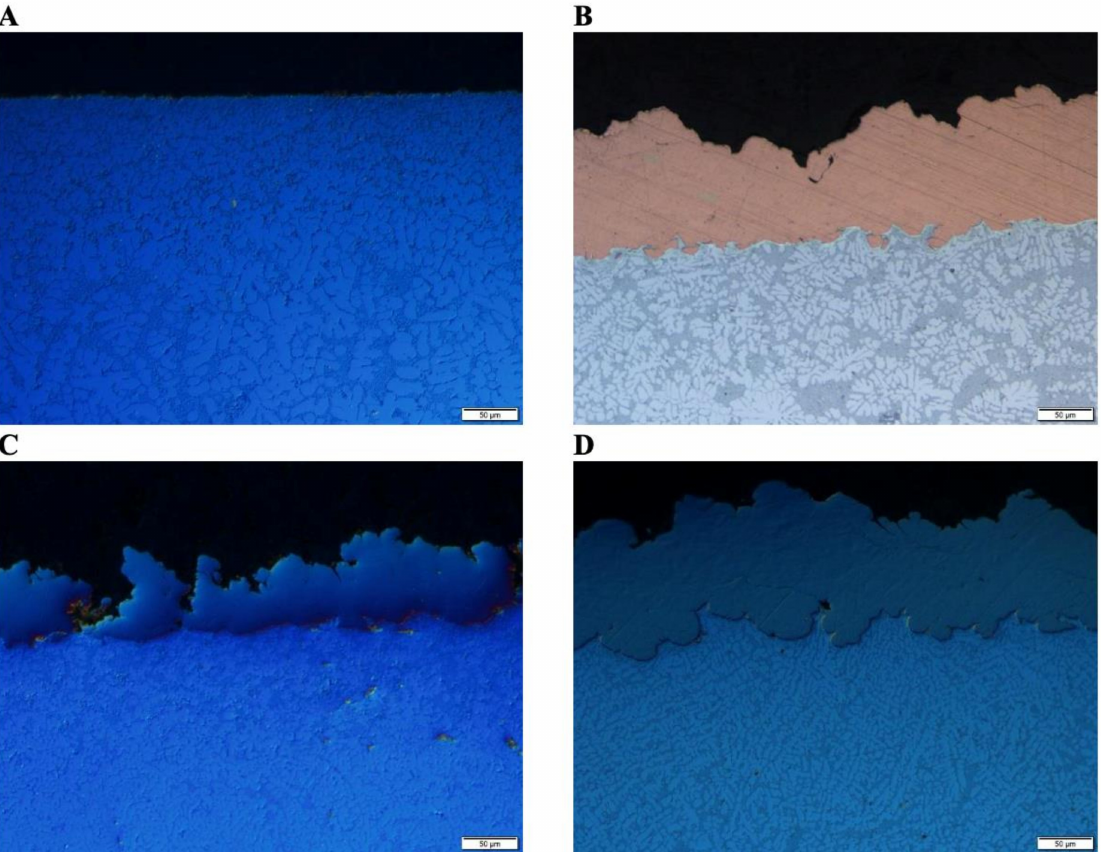
Figure 3. ( A ) Optical micrograph of the as-cast A365 HPDC. ( B ) Optical micrograph of the copper CGDS processed A365 HPDC sample. ( C ) Optical micrograph of the titanium CGDS processed A365 HPDC sample. ( D ) Optical micrograph of the nickel CGDS processed A365 HPDC sample. Black portions within the micrographs capture the mounting material. Various degrees of subsurface modification are observable within each micrograph provided. The scale bar embedded within each micrograph presented represents 50 µ